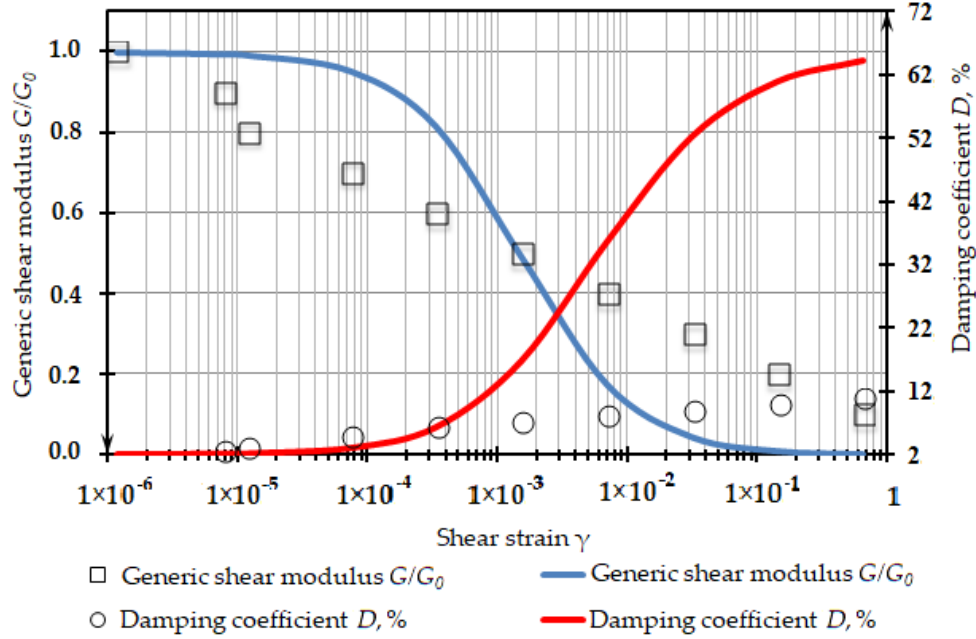
Figure 4. Approximated graph of the relationship between generic shear modulus G/G 0 (u.f.) and damping coefficient D (%), and shear strain amplitude γ (unit fractions) for soil cement with the Hardin–Drnevich model (results of six tests). Table 3. Table of recommended values of dynamic properties.